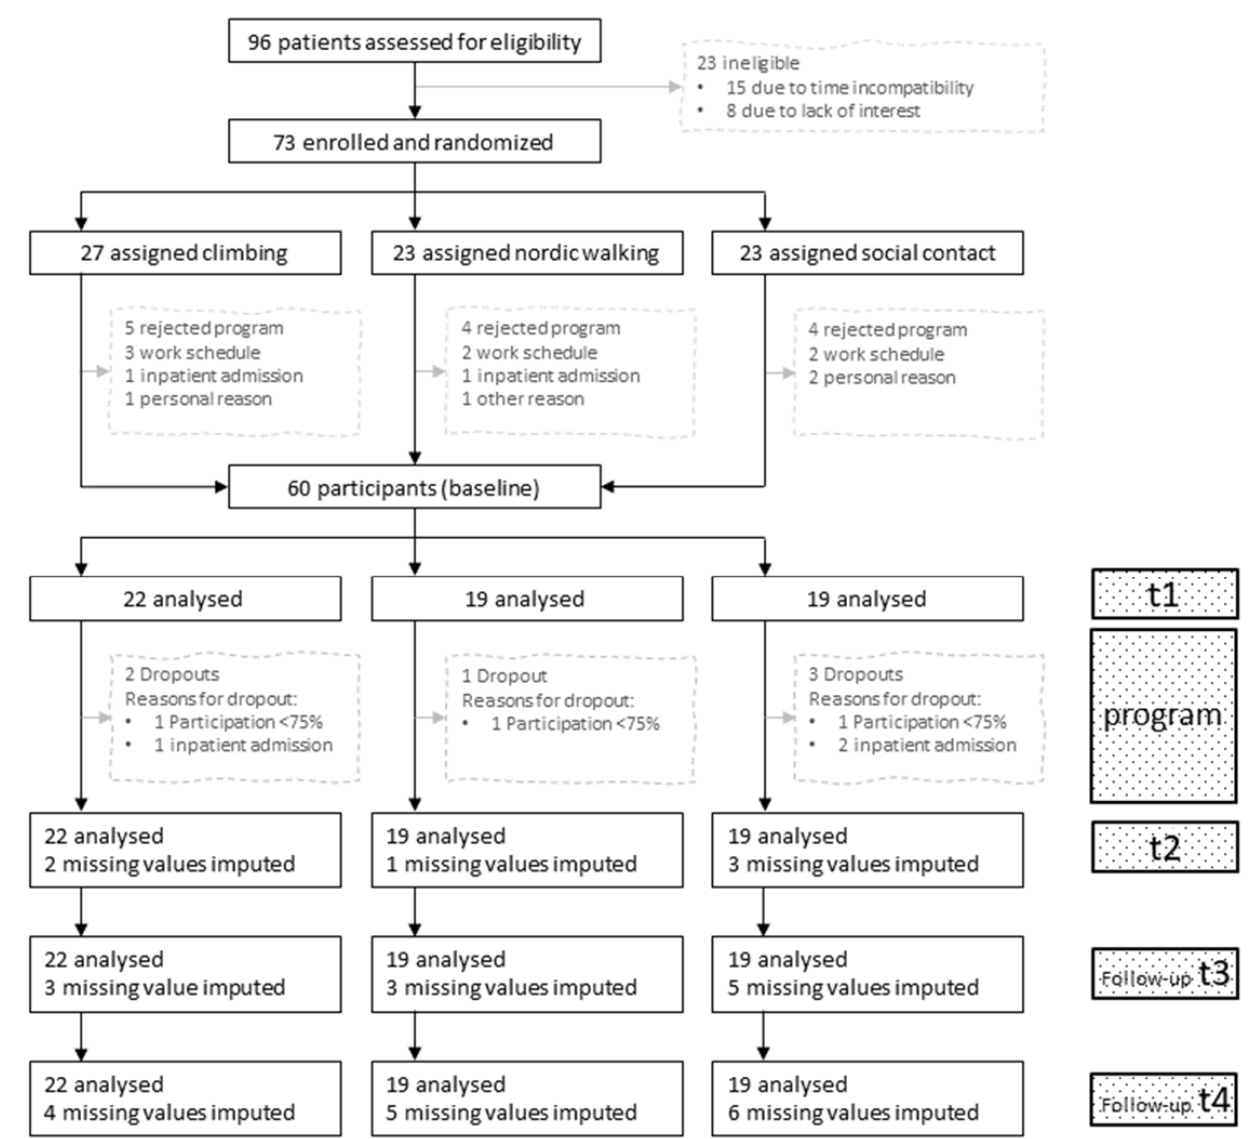
Figure 2. Participant flow. Notes: t1: before program, t2: at the end of the program, t3: three-month follow-up, t4: six-month follow-up.